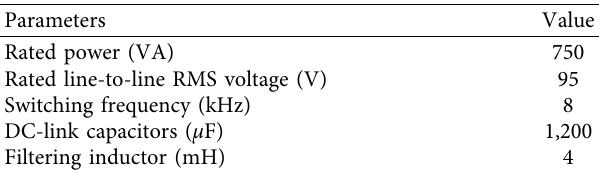
, and L X 4mH: (a) relationship of m A (cid:31) 2/3, r B (cid:31) 1 r C (cid:31) 4/3, R X (cid:31) 10 (cid:31) Ω Table 3: Parameters in the